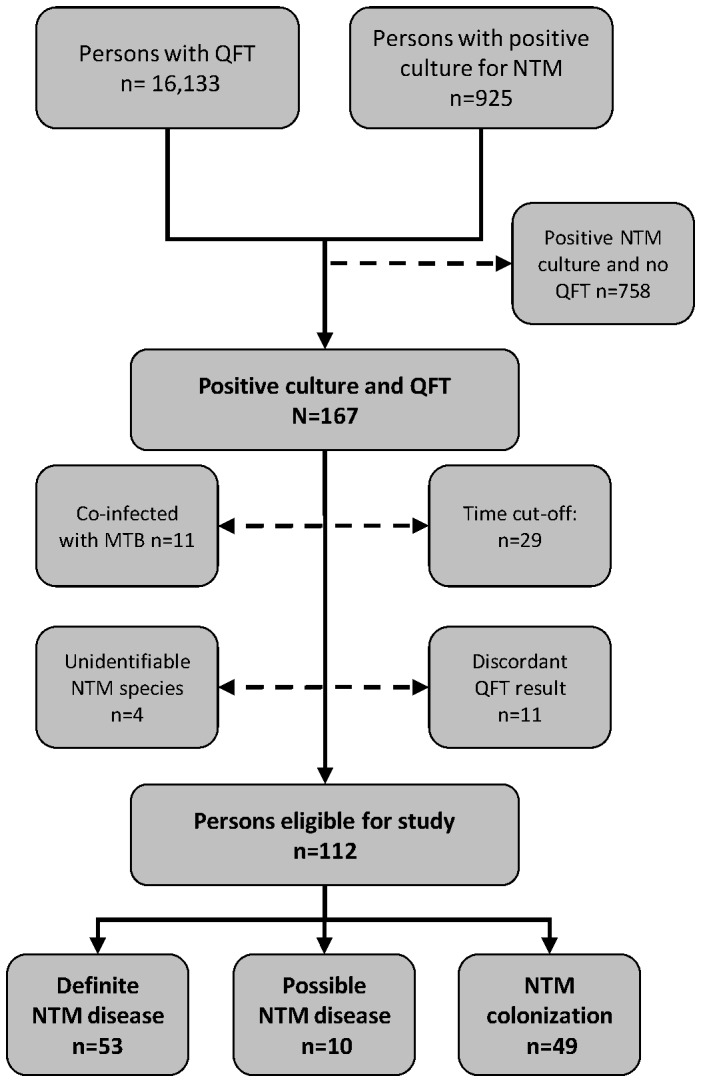
Flowchart study population.
Figure 1 illustrates the inclusion and exclusion of persons with positive NTM culture and the classification of patients into three categories on the basis of microbiological data: definite NTM disease, possible NTM disease and NTM colonization.